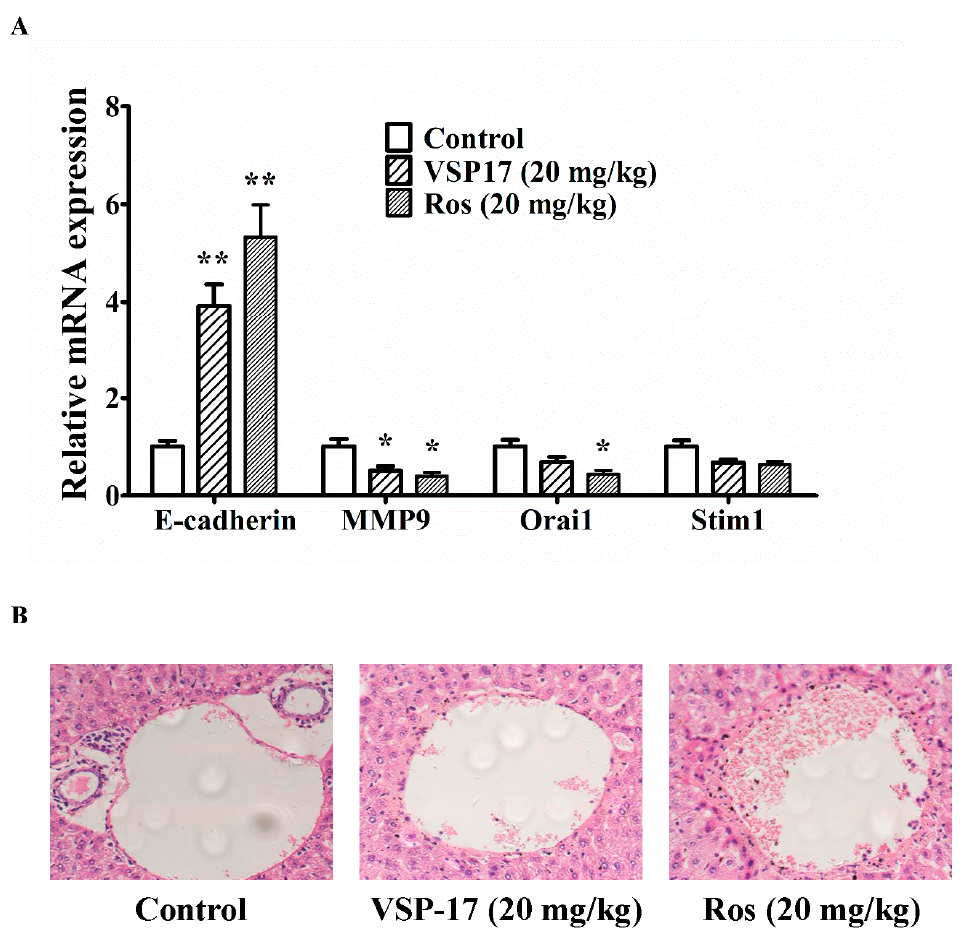
Figure 3. Effect of VSP-17 on liver metastasis of MDA-MB-231 xenograft model in vivo. Mice were injected with MDA-MB-231 cells at the left and right mammary fat pads, and then treated with VSP-17 (20 mg/kg) and rosiglitazone (20 mg/kg) for five weeks. ( A ) Tumor samples from breast of mice were collected at the end of five weeks and subjected to Q-PCR assays for E-cadherin, MMP9, Orai1, Stim1 mRNA expression; ( B ) H&E staining was used for detecting metastatic tumor cells in mouse livers. Arrows indicated infiltration of tumor cells. The data were expressed as the means ± S.E.M. of three independent experiments, n = 6. * p < 0.05, ** p < 0.01 vs. control.